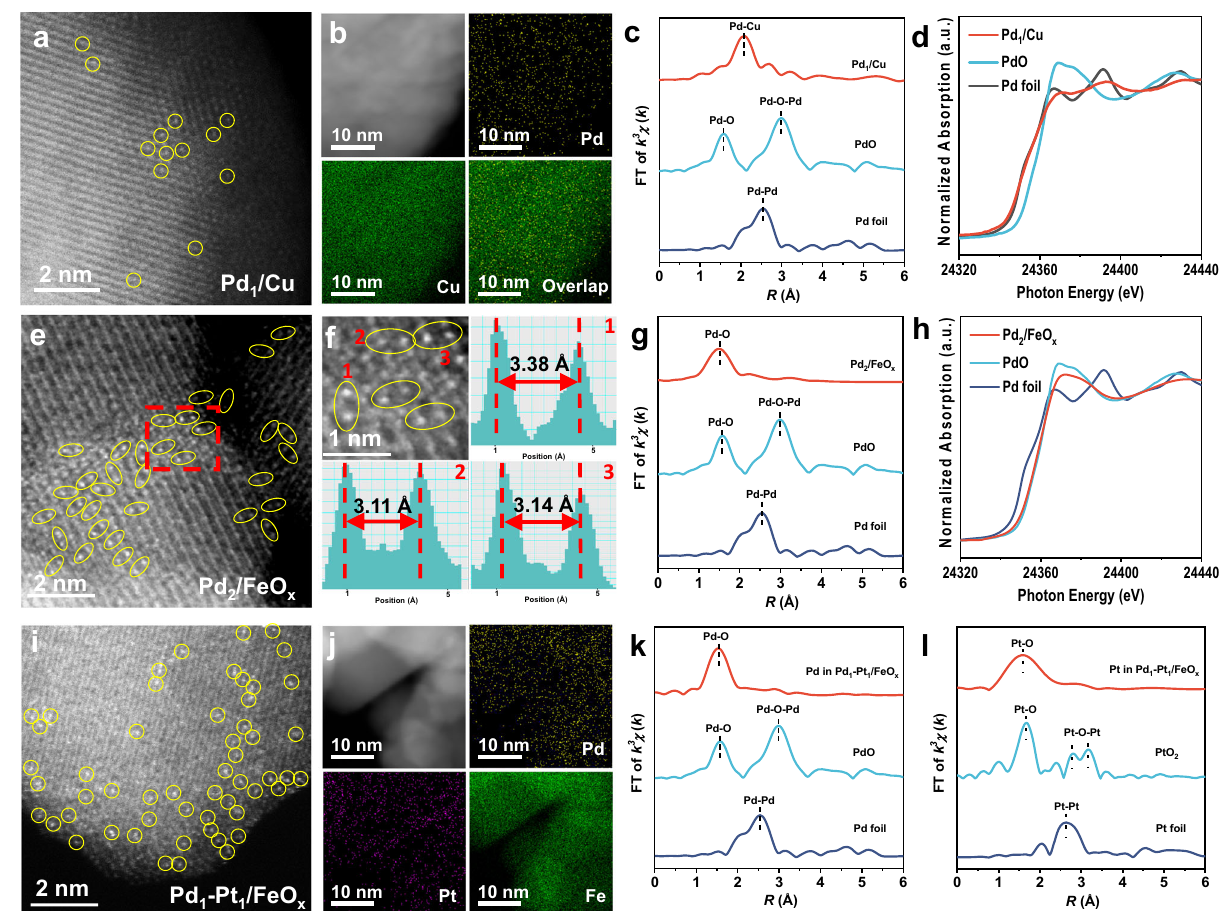
Fig.3|PreparationandstructuralcharacterizationofSACsderivatives.a – d AC HAADF-STEMimage,elementmapping,FT-EXAFS,andXANESPdK-edgespectraof Pd 1 /Cu. e – h AC HAADF-STEM image, intensity pro fi les obtained in areas labeled